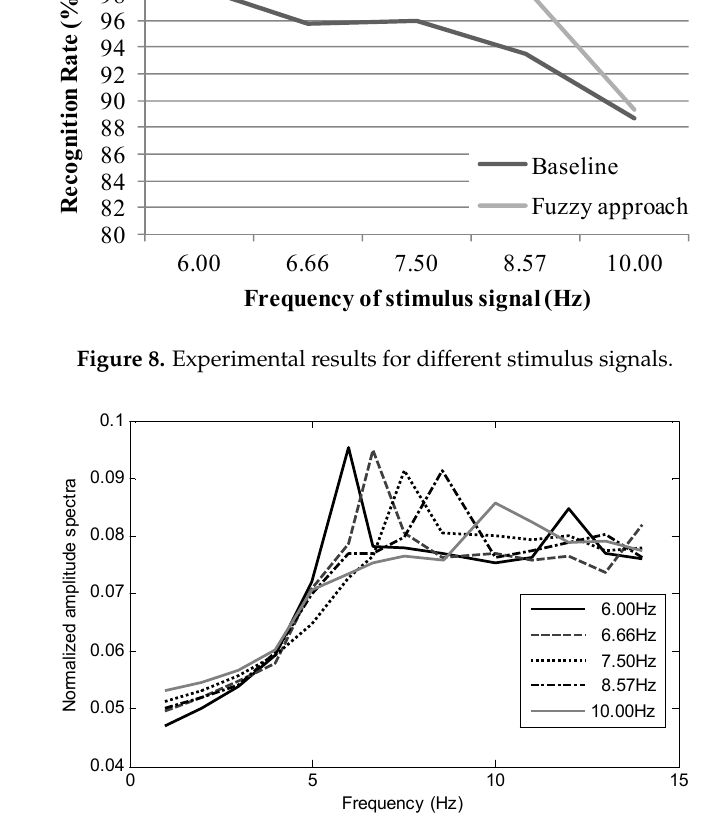
Figure 9. Electroencephalography (EEG) amplitude spectra corresponding to five different stimulus frequencies.